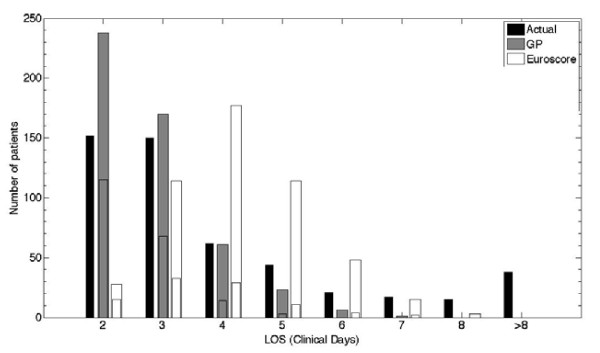
Distribution of the predictions of the regression task (validation cohort, 499 patients. GP versus EuroSCORE). The black bar indicates the actual number of patients discharged on each discrete day. Day 1 is the day of surgery (no patients were discharged on day 1), day 2 is the day after surgery, and so on. The other bars indicate the number of patients predicted to be discharged on that day. The subdivision in these bars indicates the number of true positives (predicted and actually discharged on that day).